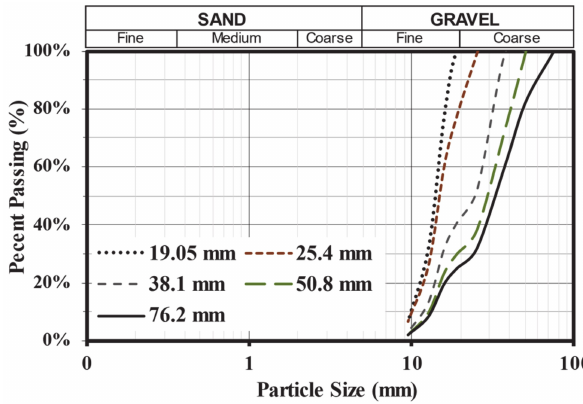
Figure 2. Gradation curves for the five samples.